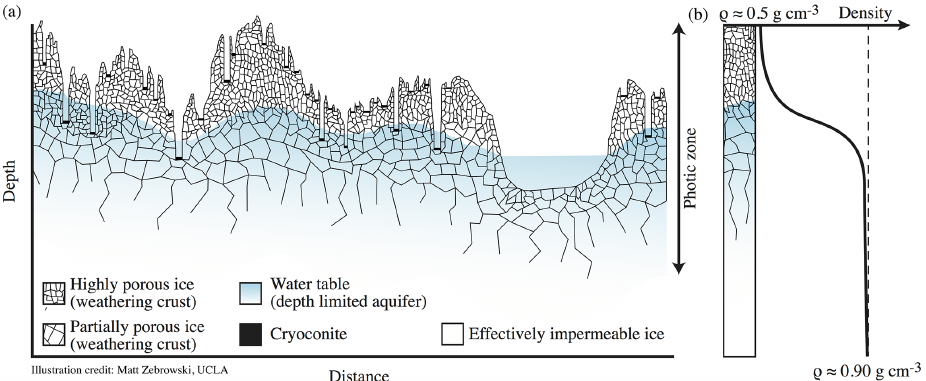
Figure 1. (a) Conceptual diagram of weathering crust structure, highlighting the porous ice layers, cryoconite holes, and saturated water table (adapted from Irvine-Fynn and Edwards, 2014 and Müller and Keeler, 1969). (b) Theoretical subsurface depth-density profile showing the non-linear increase in ice density from the highly porous, low density near-surface ice to higher-density, unweathered glacier ice (adapted from LaChapelle, 1959). Illustration credit: Matt Zebrowski,